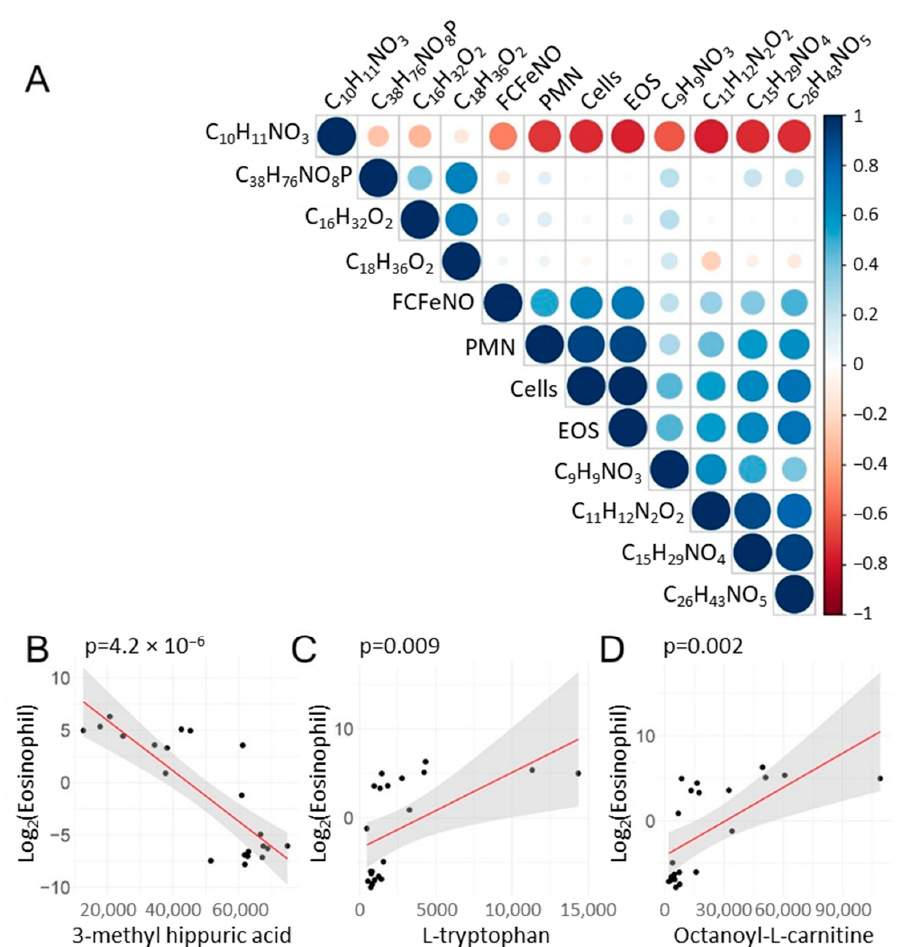
Figure 6. Correlation of metabolites and phenotypic features. Index metabolites were subjected to correlation analysis with BAL immune cell counts and FENO. ( A ) Correlation matrix correlogram from each sample (pre- and post-SBP-Ag) was used for the correlation. For each pairwise comparison, the Pearson correlation coefficient is indicated by the color scale (at right). Note the inverse correlation between 3-methyl hippuric acid (C 10 H 11 NO 3 ) and leukocyte abundance (PMN, EOS, and total cells). In contrast, a strongly positive correlation was observed between C 11 H 12 N 2 O 2 ( L -Tryptophan) and eosinophil counts and a strong correlation between C 15 H 29 NO 4 (octanoyl-L-carnitine) and eosinophil number. ( B – D ) Correlation plots of highly significant associations. ( B ) Linear regression modeling for Log 2 (Eos) vs. C 10 H 11 NO 3 (3-methyl hippuric acid) abundance. Scatterplot and linear regression (in red) shown. Confidence interval of the regression is indicated by shading. Statistical significance (p) is indicated. ( C ) Log 2 (Eos) vs. C 11 H 12 N 2 O 2 ( L